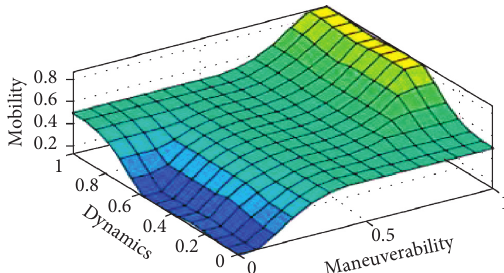
Figure 22: Fuzzy output surface for model M3.